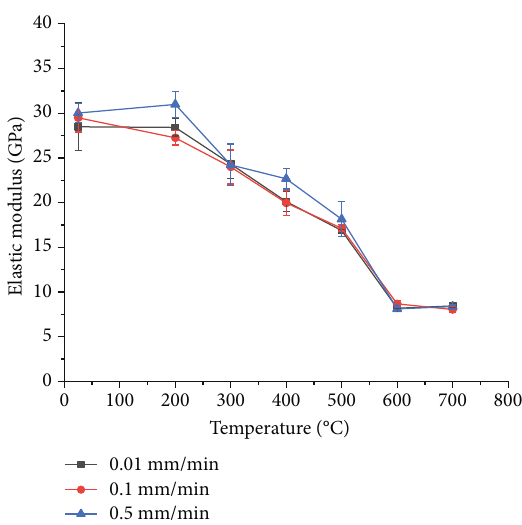
Figure 5: Relationship curves between uniaxial compression strength and temperature of granite under real-time high temperature.